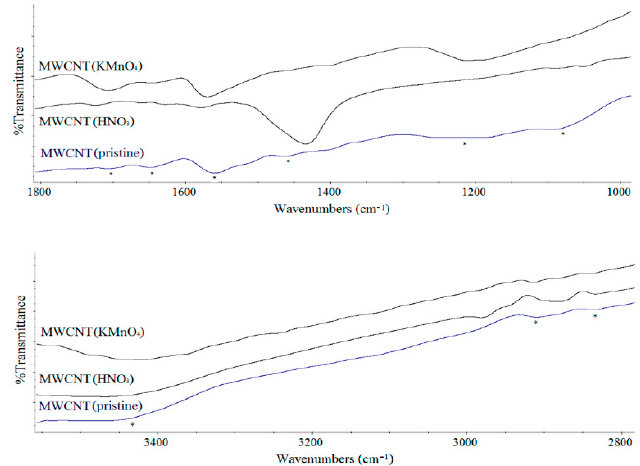
Figure 6. FTIR spectra of the MWCNT samples in the range of 1000–1800 cm − 1 and 2800–3500 cm − 1